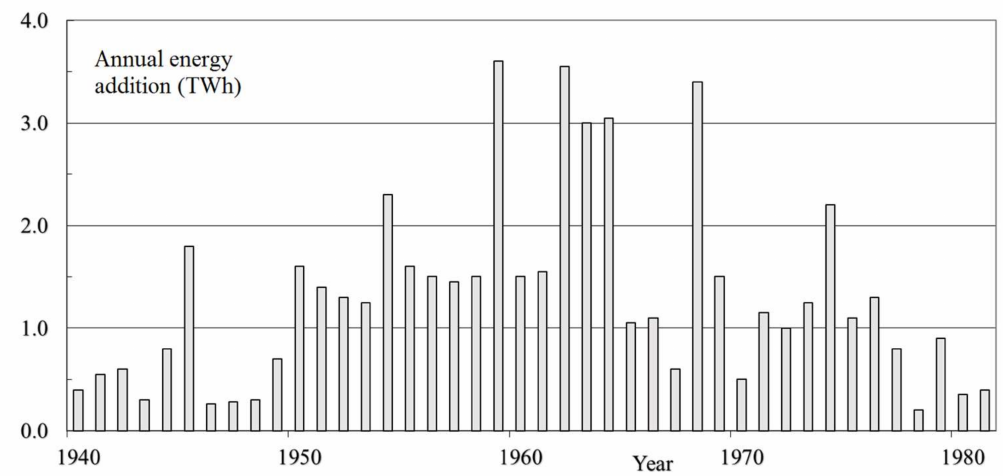
Figure 1. Annual addition of power capacity in